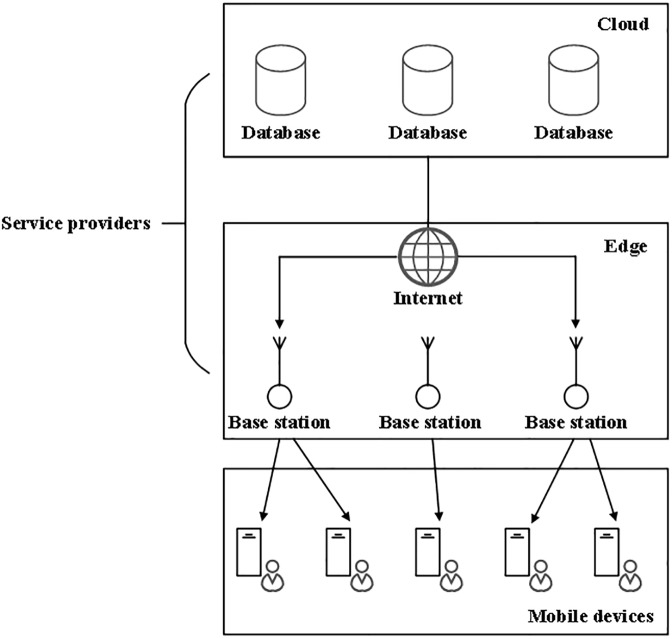
MEC architecture.